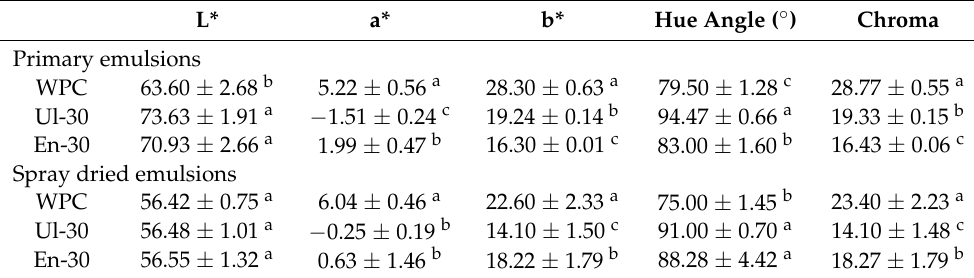
Table 4. Color properties of primary and spray dried grape seed oil in water